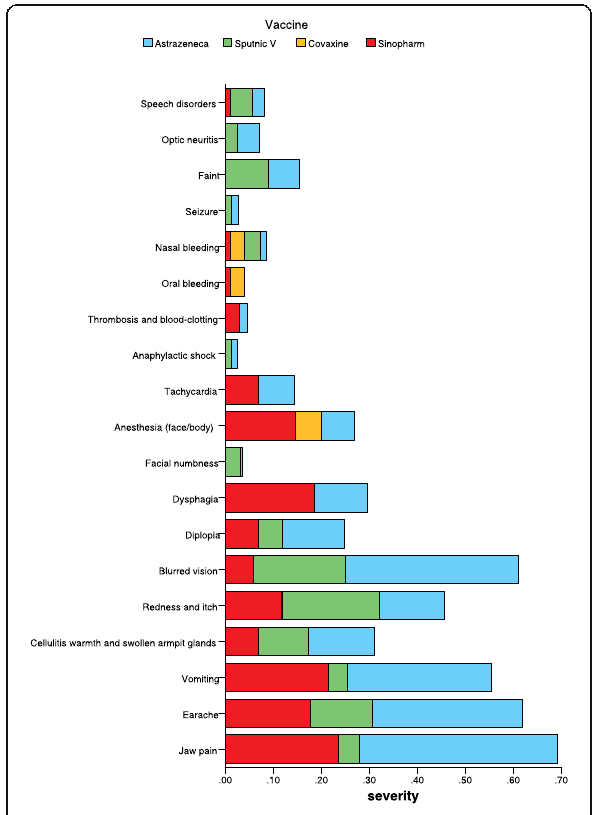
Fig. 2 Continue of the symptoms ’ intensity on 0 – 10 Numeric Rating Scale in four types of vaccine; ChAdOx1 nCoV-19, Gam-COVID-Vac, BBV152, and